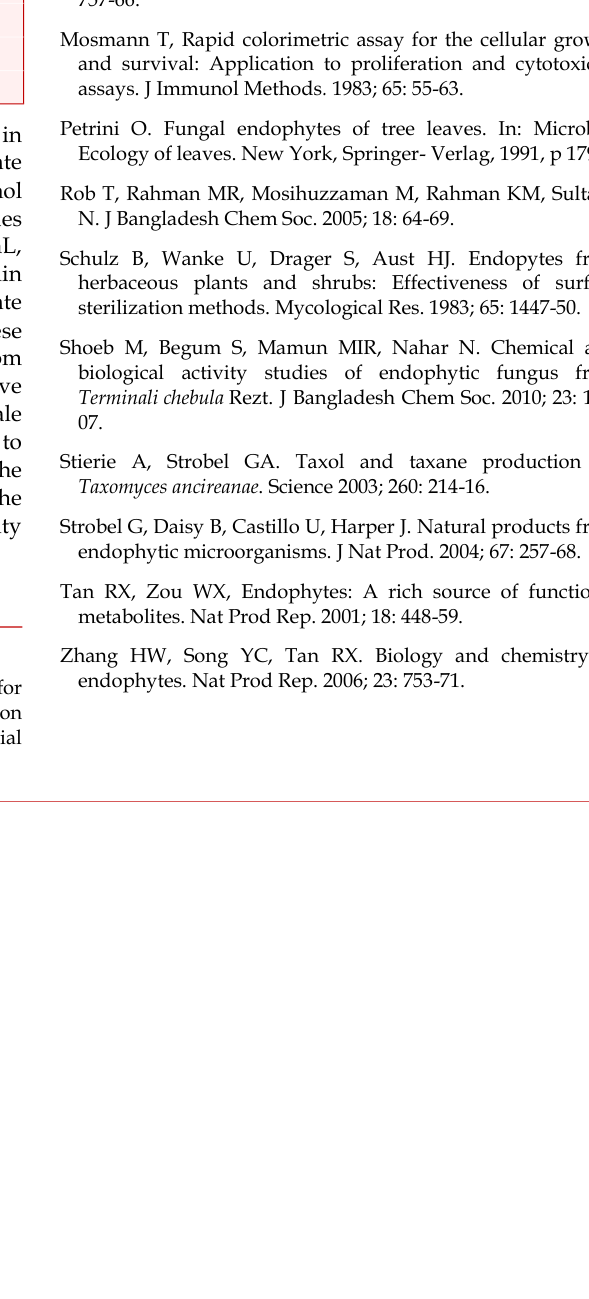
Table I MTT cytotoxicity assay of extracts of endophytic fungi from T. chebula Extracts Cytotoxicity (µg/mL) Ethyl acetate extract of